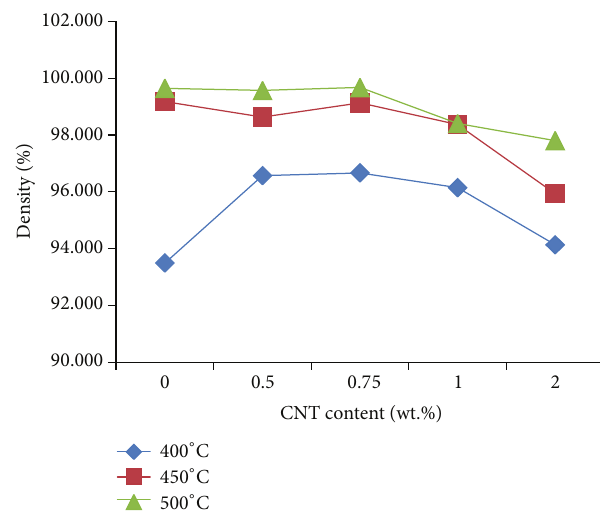
Figure 8: Relative density of CNT reinforced Al2124 nanocompos- ites.